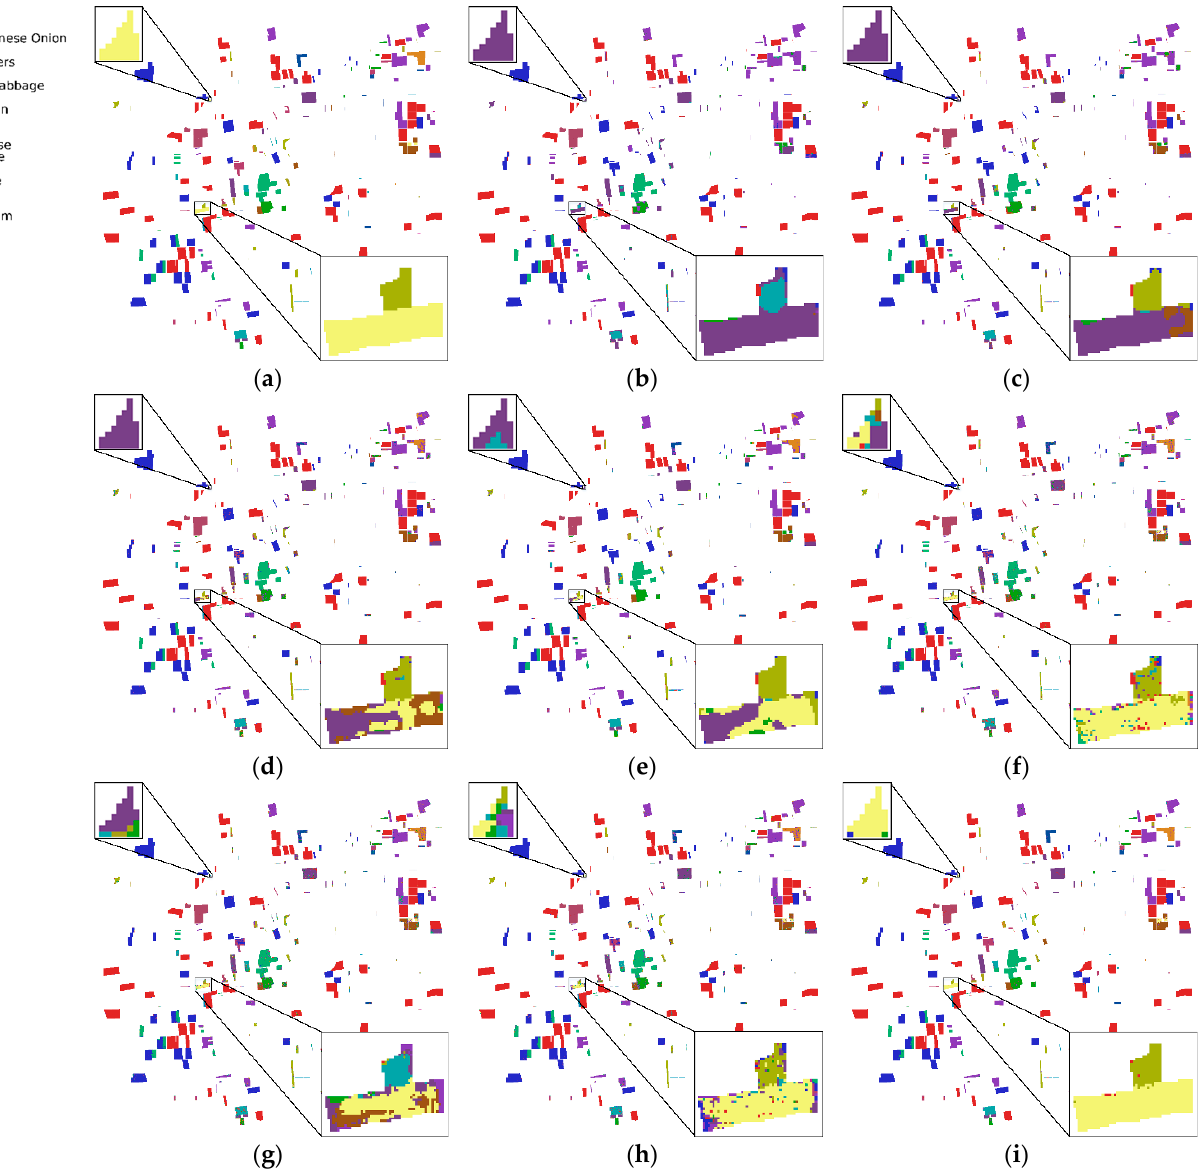
Figure 7. Classi fi cation results of di ff erent algorithms on the GF14 dataset: ( a ) ground truth; ( b ) 2D- CNN; ( c ) 3D-CNN; ( d ) SSRN; ( e ) HybridSN; ( f ) SSAN; ( g ) ViT; ( h ) DMVL; ( i ) SSACT. The GF14 satellite hyperspectral image dataset is the closest to the practical applica- tion. The distribution of di ff erent objects is obtained by fi eld mapping. The cost of obtain- ing labeled samples is very high, but it gives us an important reference for satellite hyper- spectral image classi fi cation research. From the overall classi fi cation e ff ect, the noise and